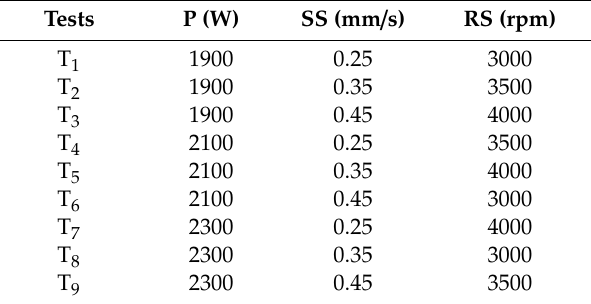
Table 5. Experimental design using L 9.